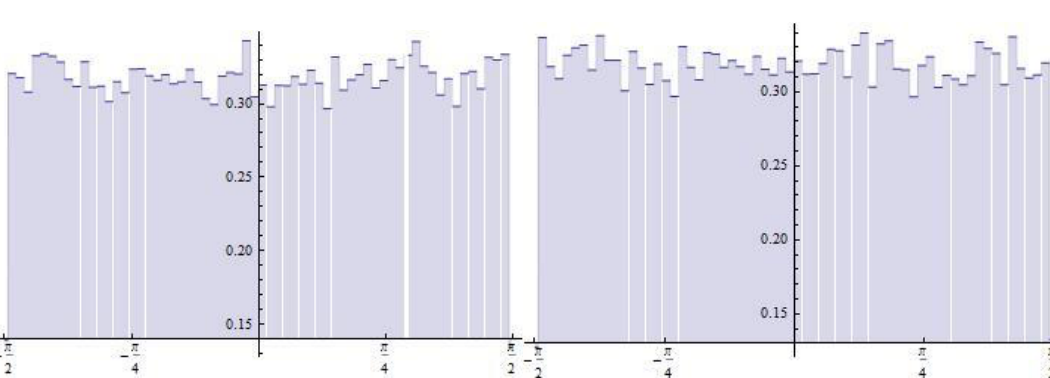
Figure 6. Cipher image histograms based on the weighted data for the fractal image (Figure 1 on the left side): after encryption with the 2D QRT linear map in Eq. (28) (left) for 0 . 15   , and after encryption with the 2D mKdV linear map in Eq. (29) (right).